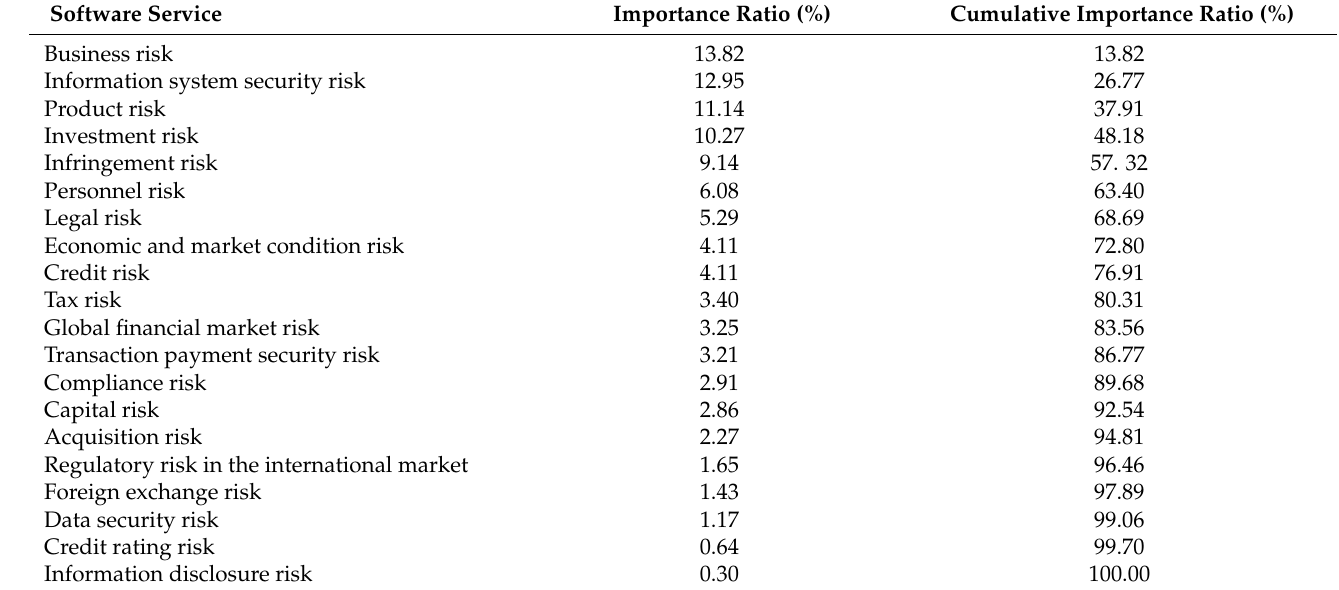
Table 10. The importance ratios of risks faced by the software service industry from 2015 to 2019.